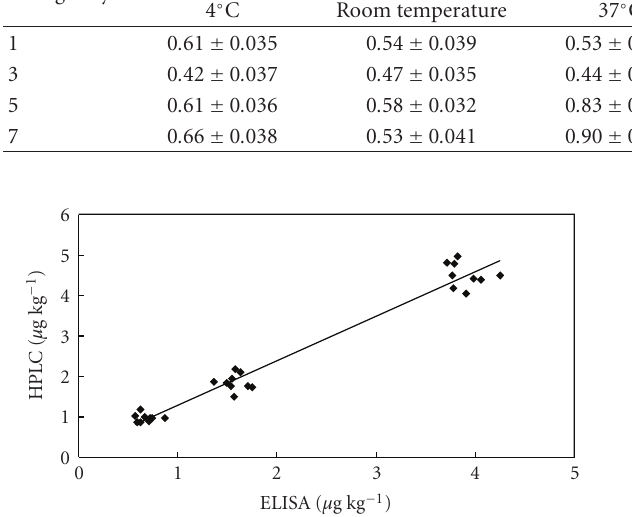
Figure 6: Correlation between ELISA and HPLC results for purified pig liver spiked with ractopamine at three levels ( y = 1 . 097x + 0 . 1978, R 2 = 0 . 9677, n = 9).